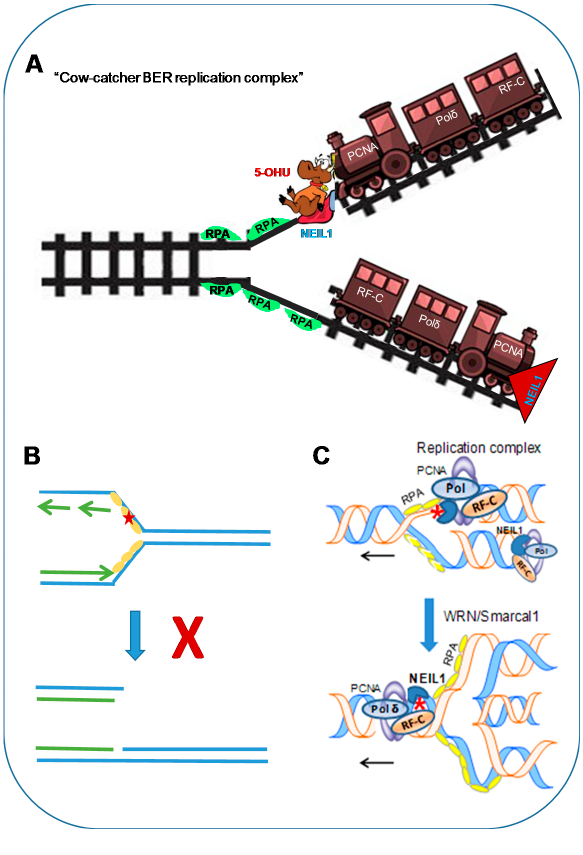
Figure 3. ( A ) ‘Cowcatcher’ model of pre-replicative repair. NEIL1 as part of the replication machinery surveils base lesions in template DNA. ( B ) Its binding to lesion site in RPA-bound ssDNA without removing the lesion is a critical step which would prevent double-stranded break (DSB) formation. ( C ) The resulting stalling and regression of the fork brings the lesion in the re-annealed duplex for faithful repair. 5-OHU: 5-hydroxyuracil; Smarcal1: SWI/SNF related, matrix-associated, actin-dependent, regulator of chromatin, subfamily A-like